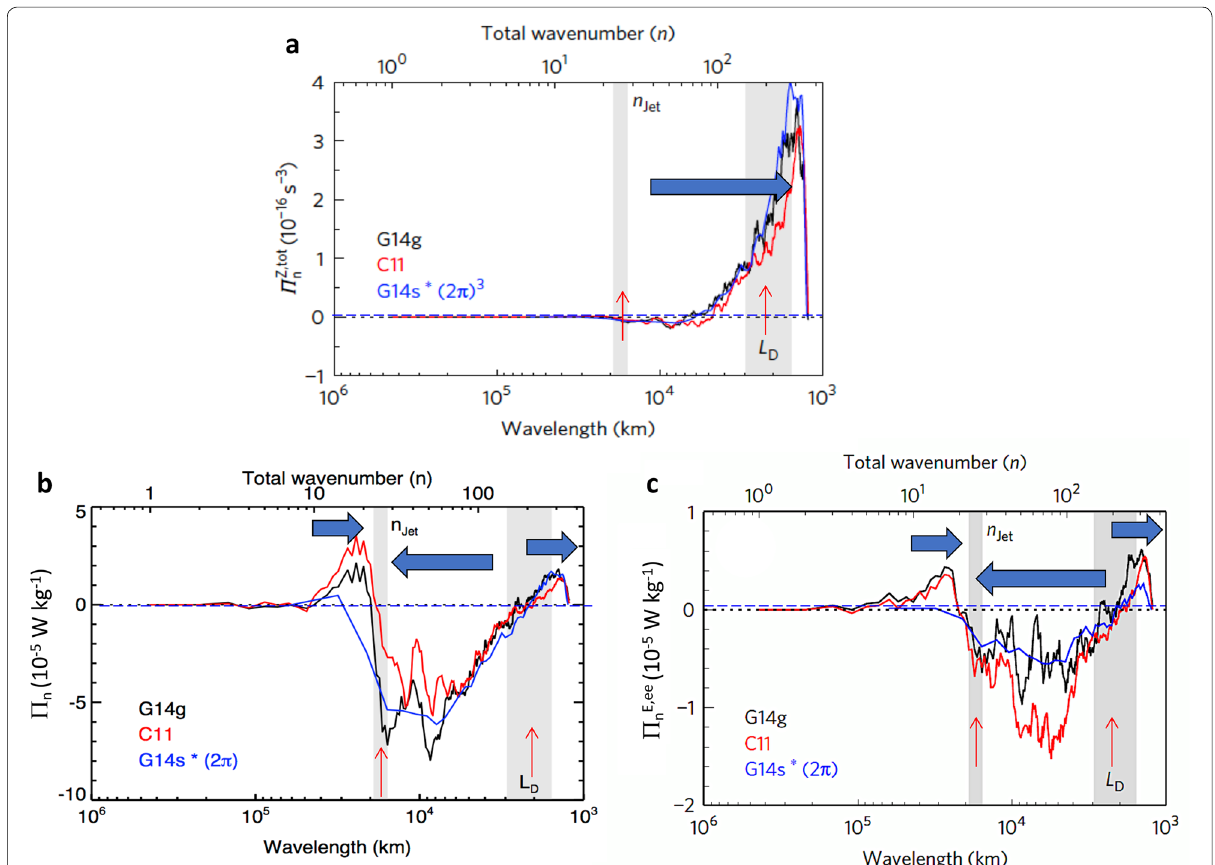
Fig. 2 Profiles of spectral fluxes of enstrophy (squared vorticity) and kinetic energy with total horizontal wavenumber and wavelength at Jupiter’s cloud tops, as derived from Cassini ISS images of Jupiter during the 2000 fly-by by Young and Read (2017). a Enstrophy flux, b total (rotational) kinetic energy flux and c kinetic energy flux due only to eddy–eddy interactions. The direction of energy or enstrophy transfer is indicated by the arrows. G14g and G14s refer, respectively, to the global mosaic and single image cloud tracking analyses of Galperin et al. (2014) while C11 refers to the global mosaic analysis of the same images by Choi and Showman